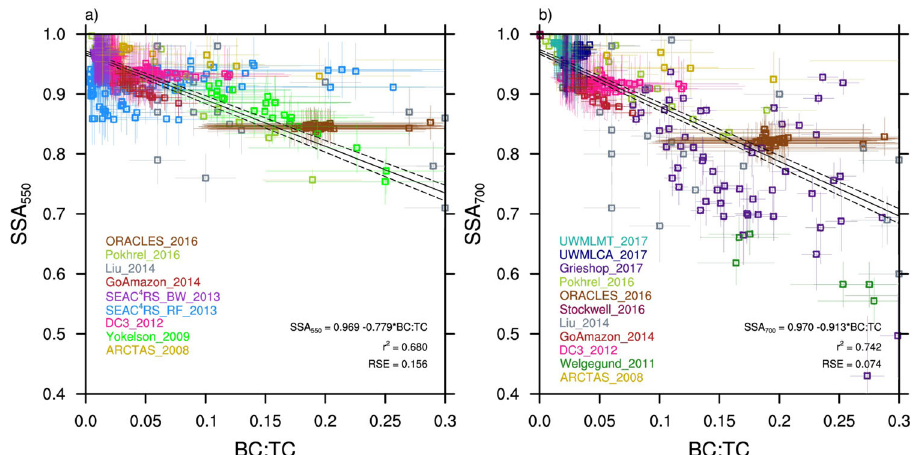
Fig. 1 Observations of biomass burning single scattering albedo versus black carbon to total carbon ratio. a Single scattering albedo (SSA) at 550 nm wavelength versus black carbon to total carbon ratio (BC:TC) and b SSA at 700 nm wavelength versus BC:TC. Included are the linear regression equation, the r 2 value, and the residual standard error (RSE). Dotted lines represent the 95% con fi dence intervals of the fi t. Different observations are color-coded, and measurement uncertainty is plotted when